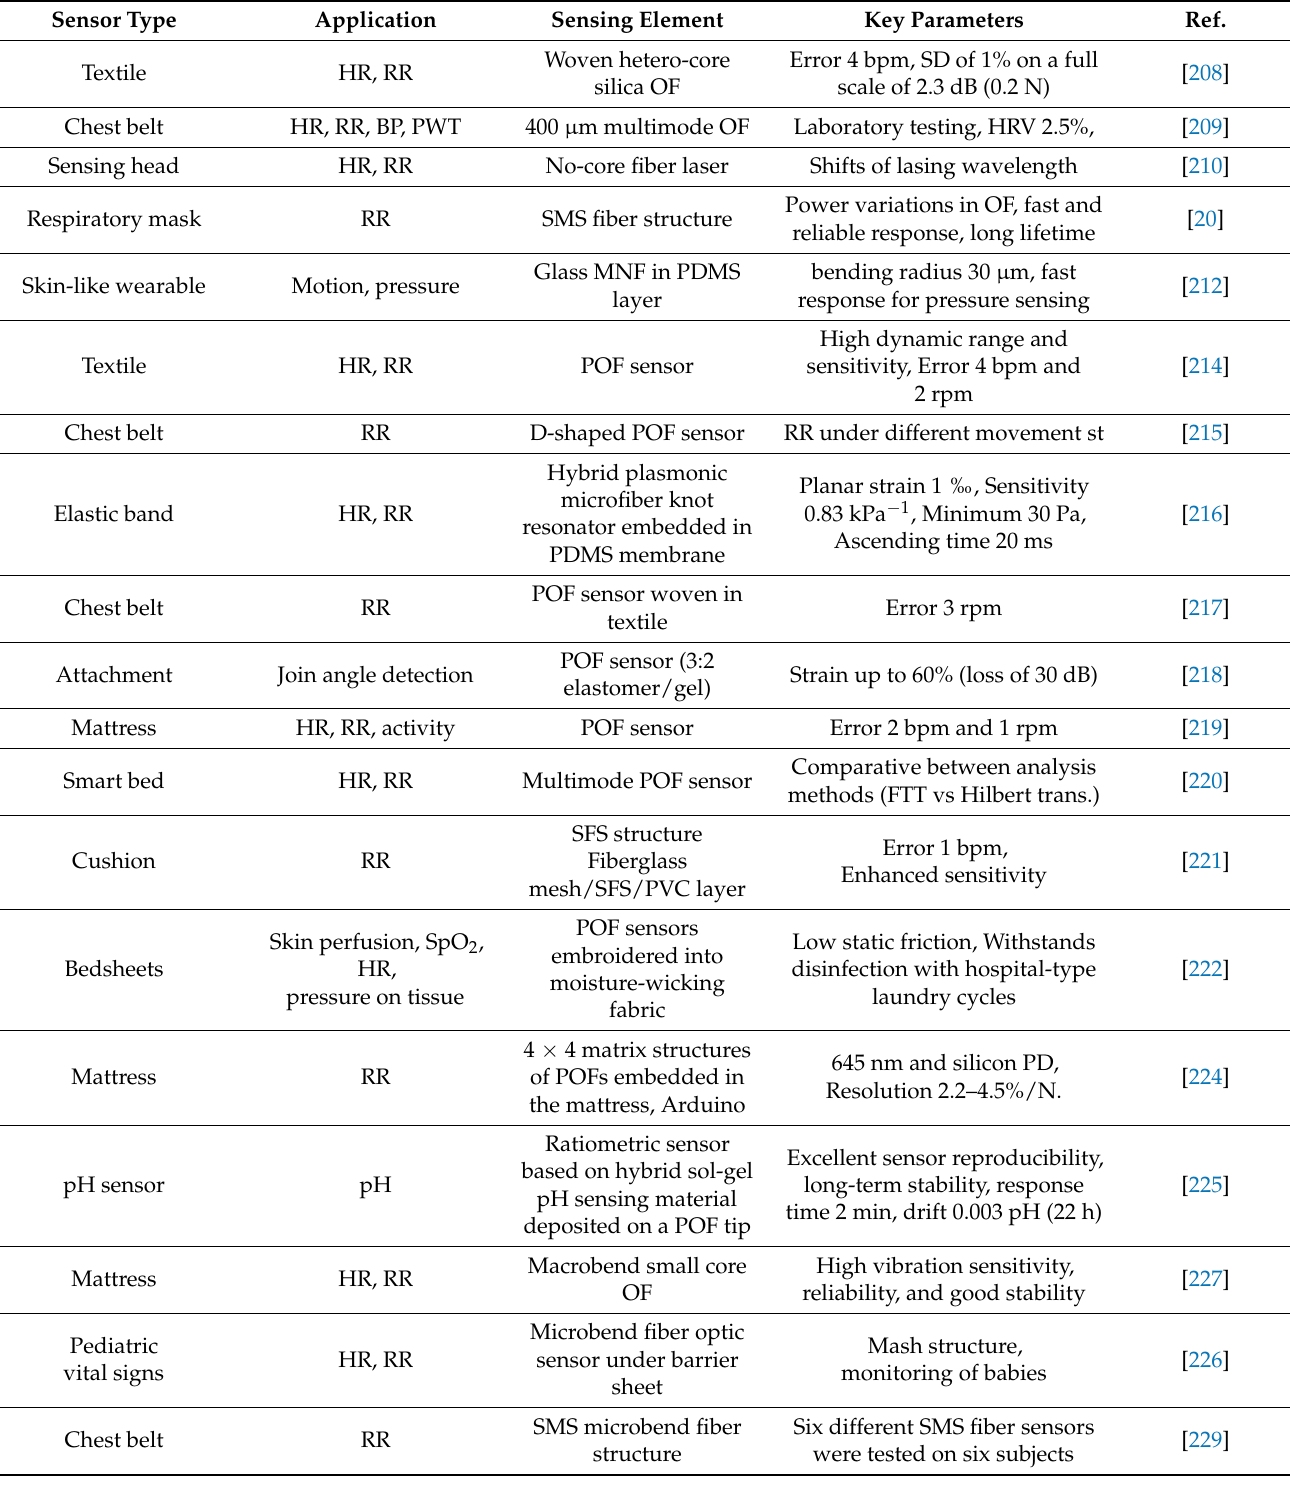
Table 3. Optical fiber